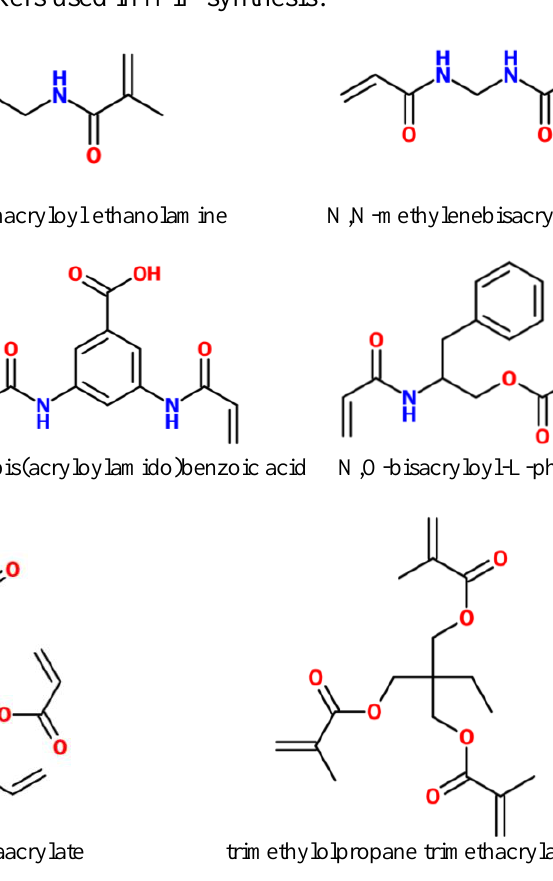
Figure 2. Some cross-linkers used in MIP